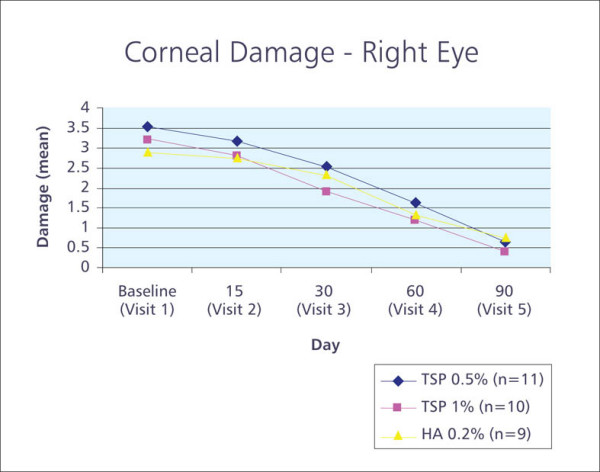
Graph showing corneal staining total score over time.